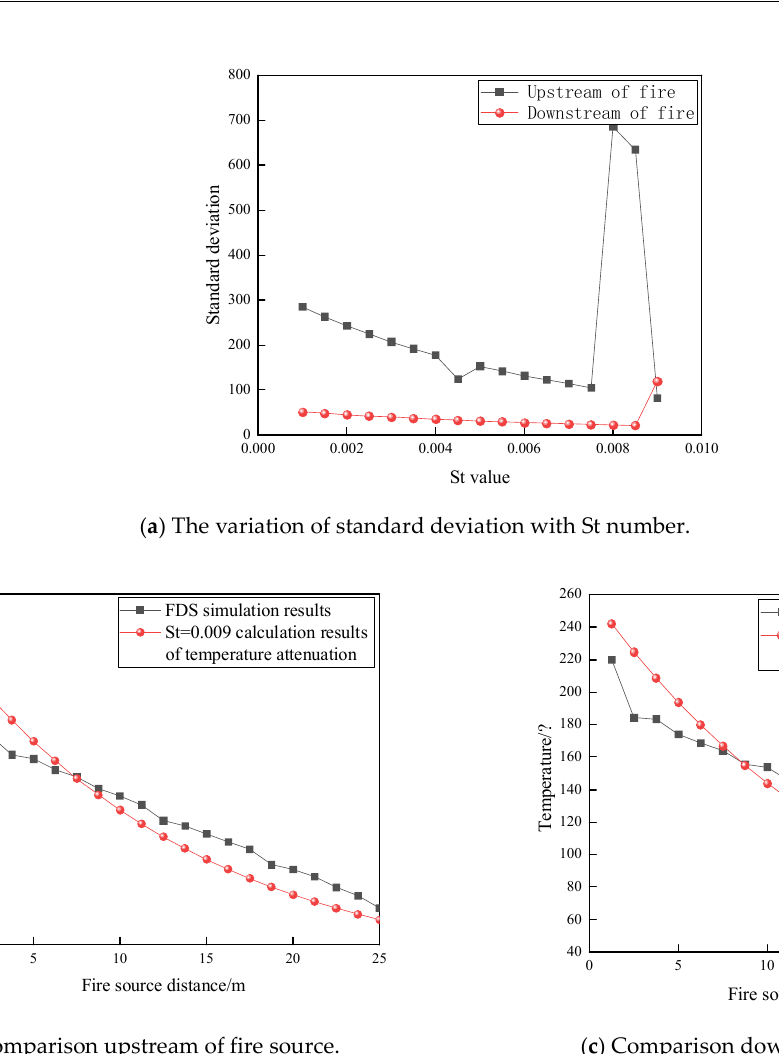
Figure 6. Temperature attenuation simulation results and calculation results.